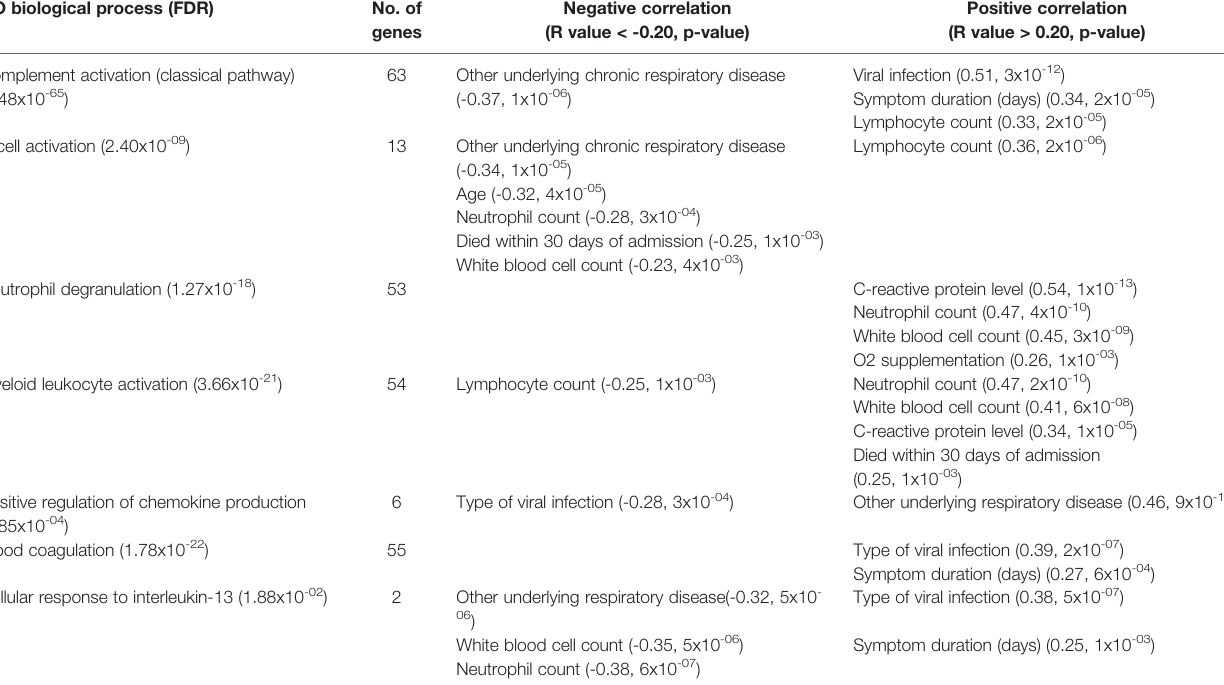
TABLE 4 | Clinical covariates and their correlation with different gene transcript clusters. GO biological process (FDR) No. of